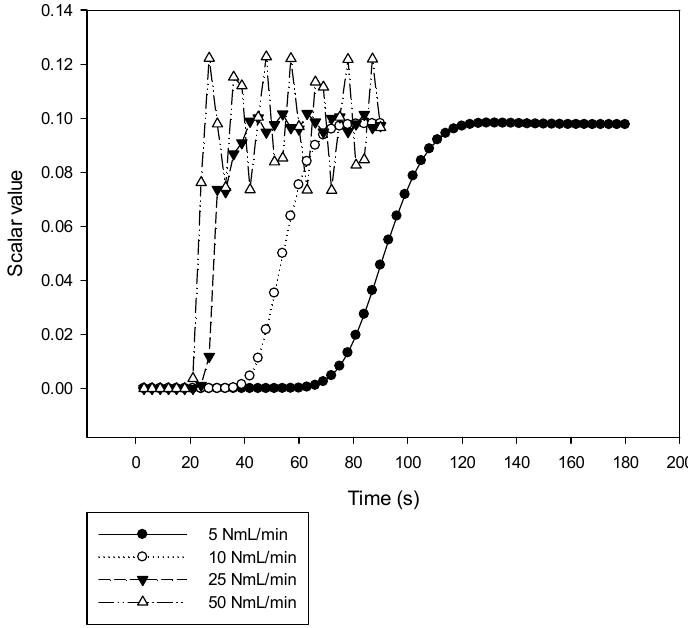
Figure 5. Effect of different flow rates on the variations of the scalar variable as a function of time at the exit of the last stage of a 4-stages micromixer.